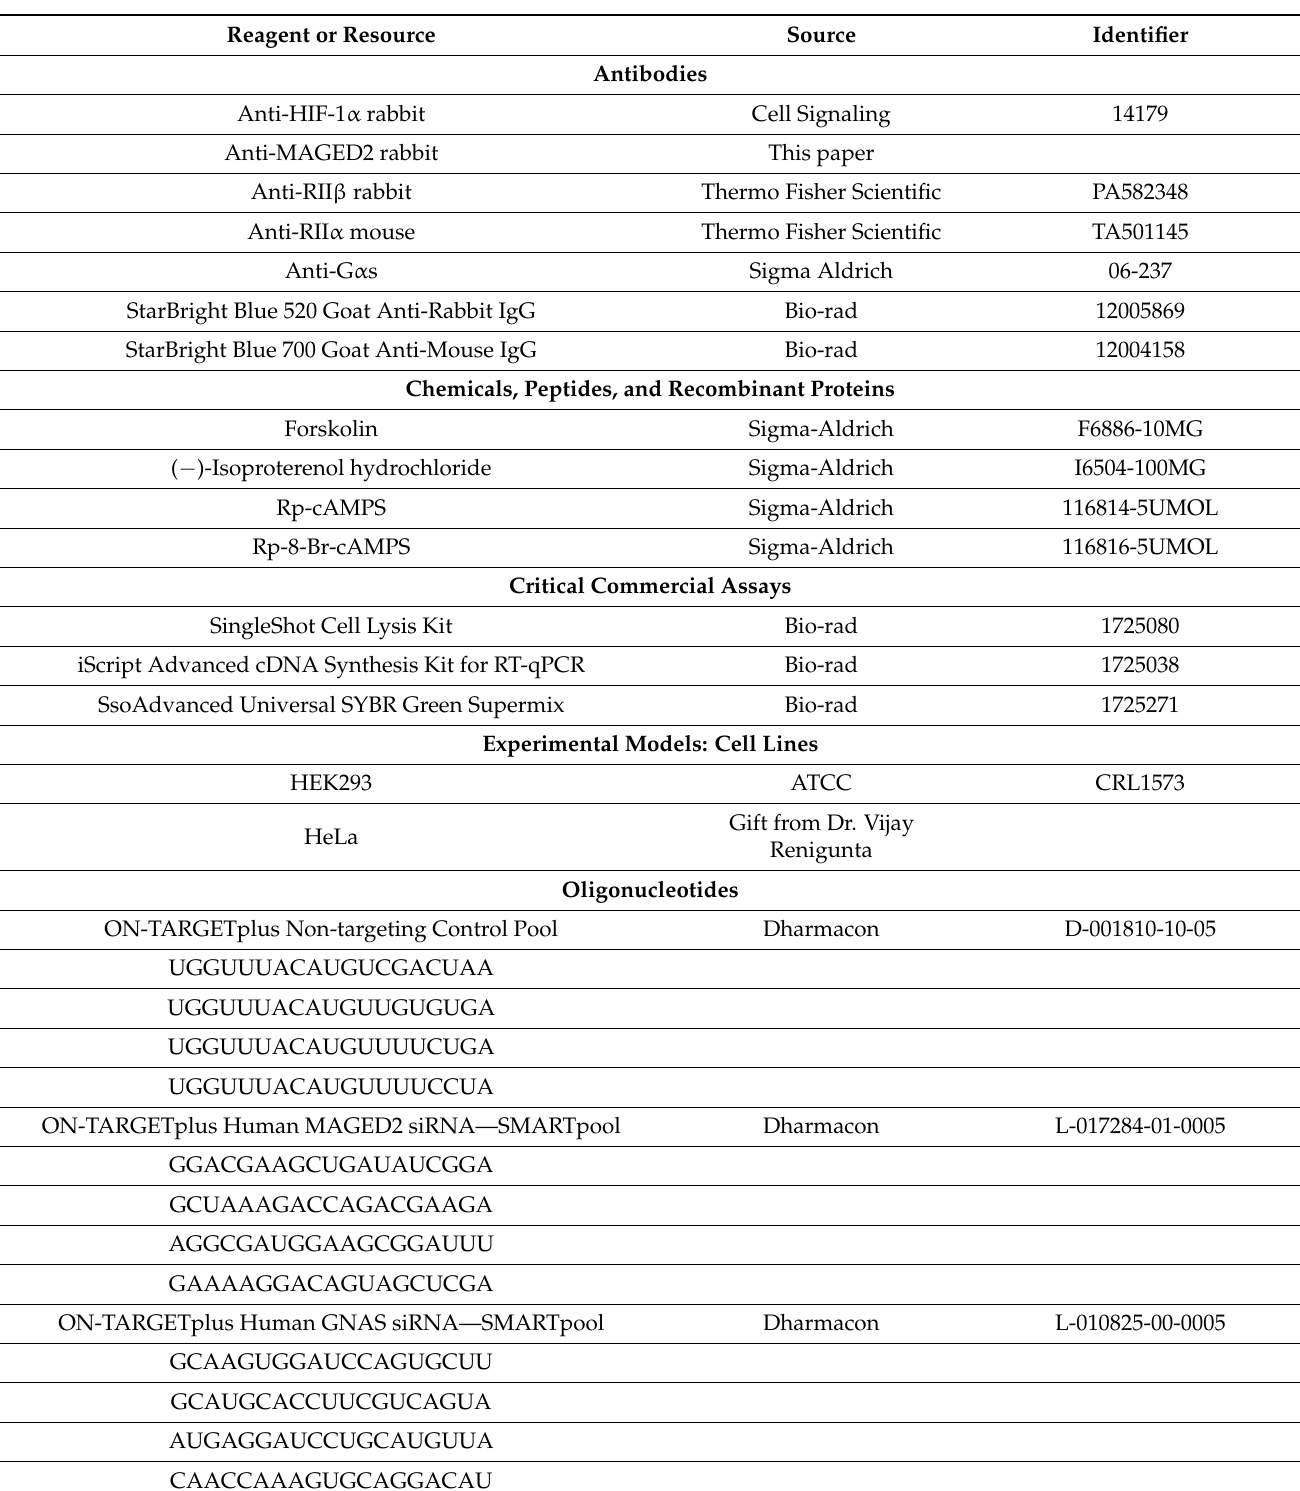
Table 1. Reagents and